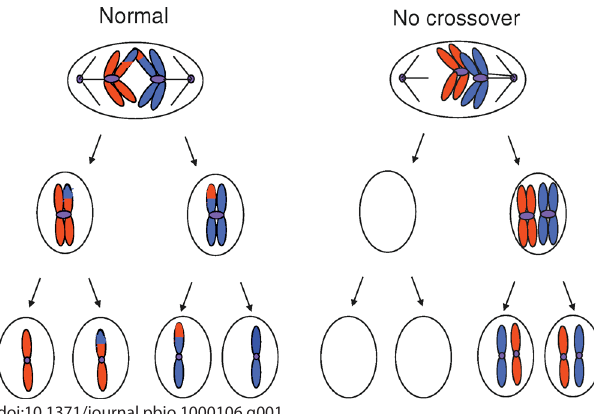
Figure 1. In the Absence of Crossing Over, Chromosomes Mis- Segregate Tension provided by the proteinaceous structures called chiasmata, which are associated with crossovers, allows the chromosomes to be oriented correctly at metaphase. In the subsequent division, each gamete gets one parental chromosome. In the absence of any crossovers, both chromosomes can be carried to the same pole of the cell. At the second meiotic division, this results in two gametes with twice the number of chromosomes than they should have. In humans, the majority of such gametes do not lead to viable progeny. However, this type of mis-segregation of Chromosome 21 in maternal meiosis leads to trisomy 21—or Down syndrome—when the oocyte is fertilized by a normal